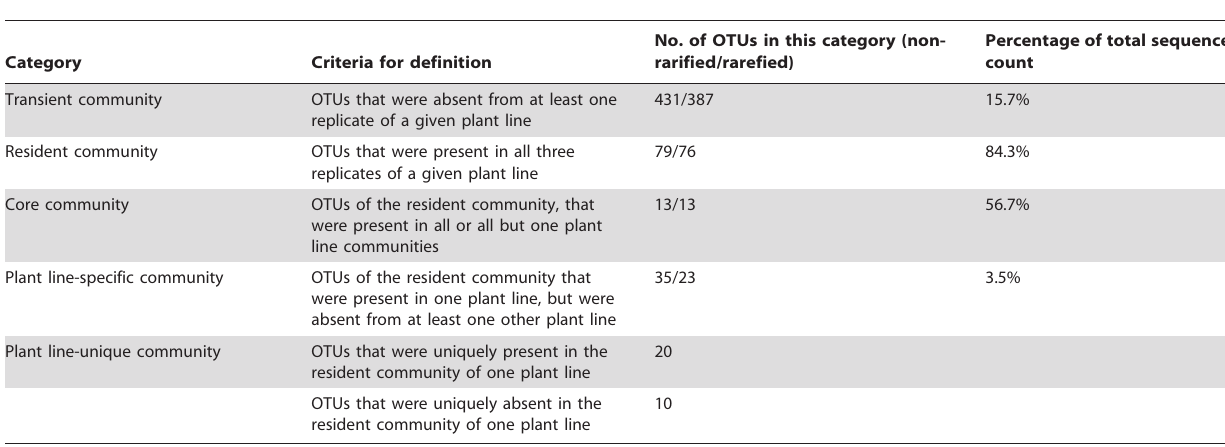
Table 2. Categories of bacterial phylotypes from the amplicon dataset.